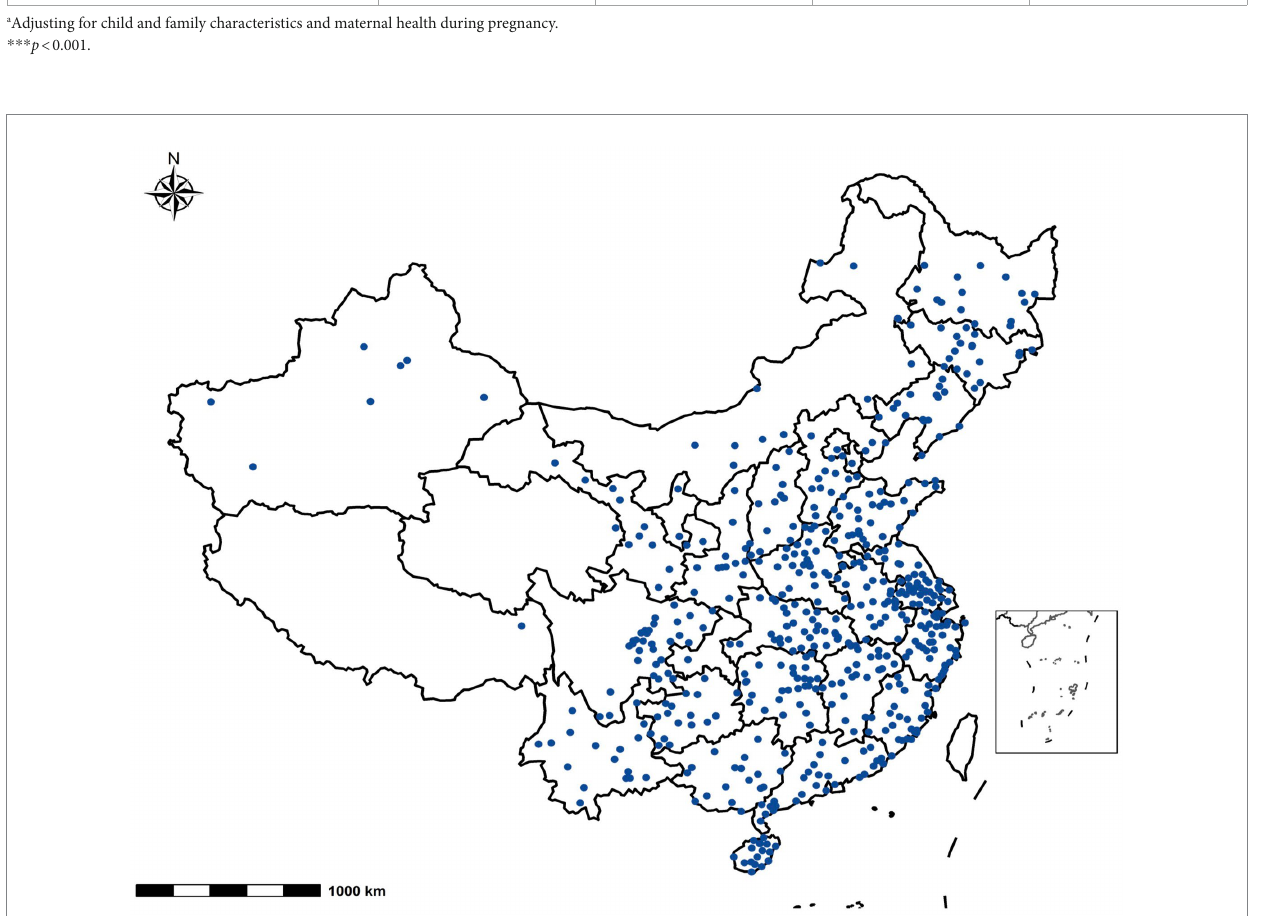
found to improve motor coordination in ethanol-hungover mice (52), and treatment with melatonin could promote motor performance in nocturnal animals (53). Additionally, prolonged screen exposure was